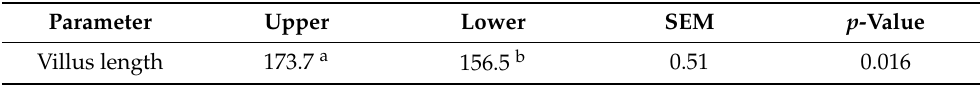
Table 5. Villus length ( µ m) was reported for the upper and lower surface of the intestinal lumen, independently from the dietary